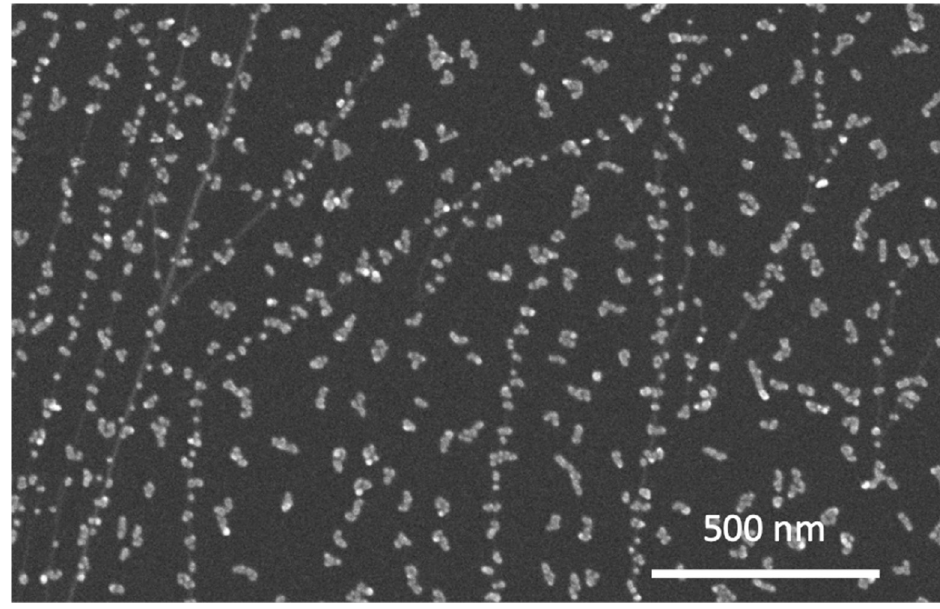
Figure 3. SEM image of Cu NP deposited on HOPG. t = 0.2 nm, C = 4%.